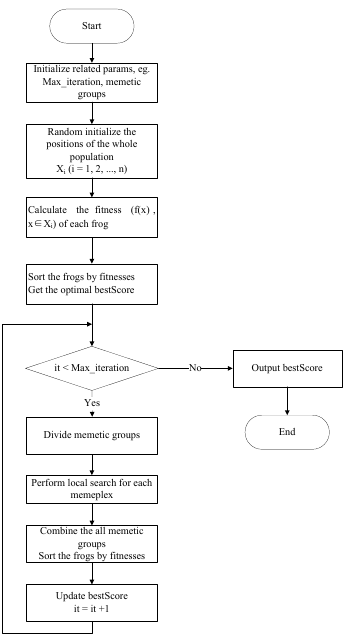
Figure 4. The overall flow chart of SFLA.